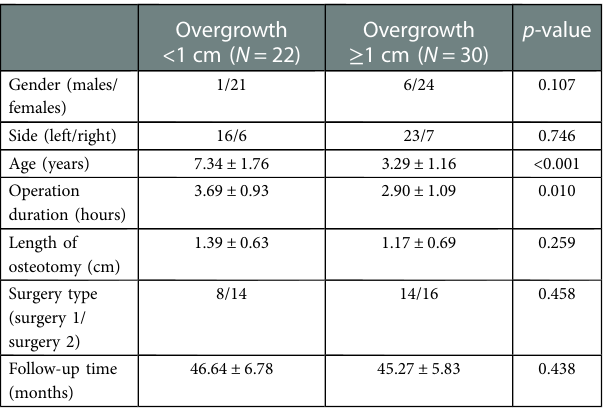
TABLE 2 Comparison of variables between the two groups of patients with femoral overgrowth <1 cm and ≥ 1 cm.